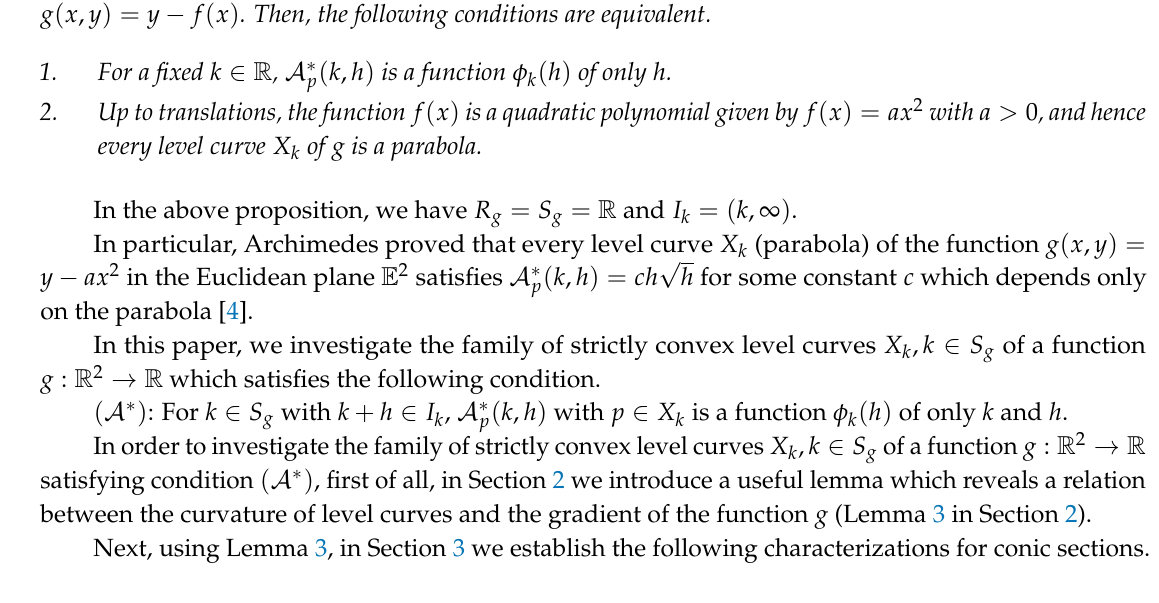
Figure 1. A ∗ p ( 1, − 3/4 ) for p = ( 1,